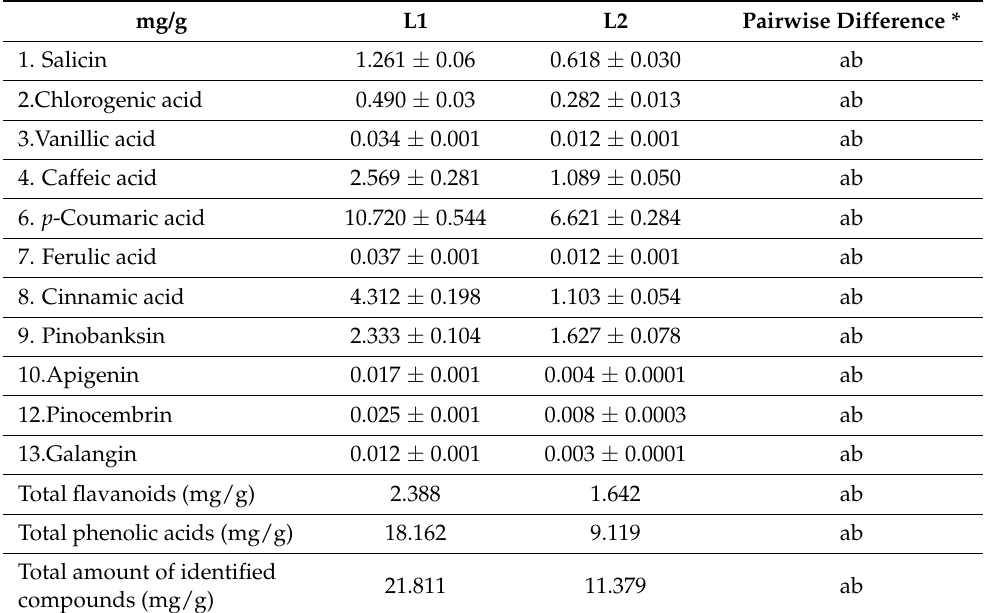
Table 3. HPLC analysis of L1: lyophilized 1% aqueous solution of balsam poplar buds extract; and L2: aqueous balsam poplar buds extract (mean mg/g ± SD of dry weight, n = 3). mg/g L1 L2 Pairwise Difference *